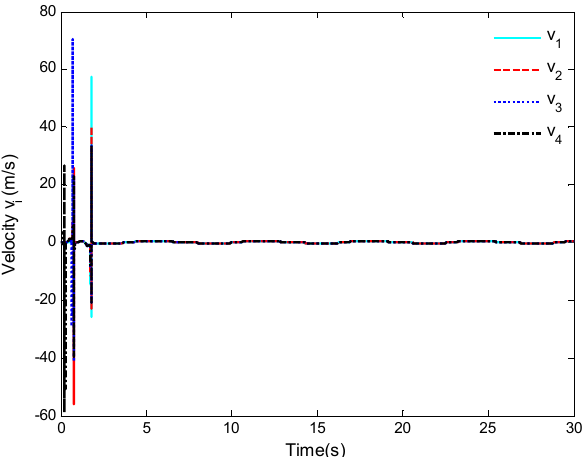
Figure 5. The curves of the agents' velocity v i .